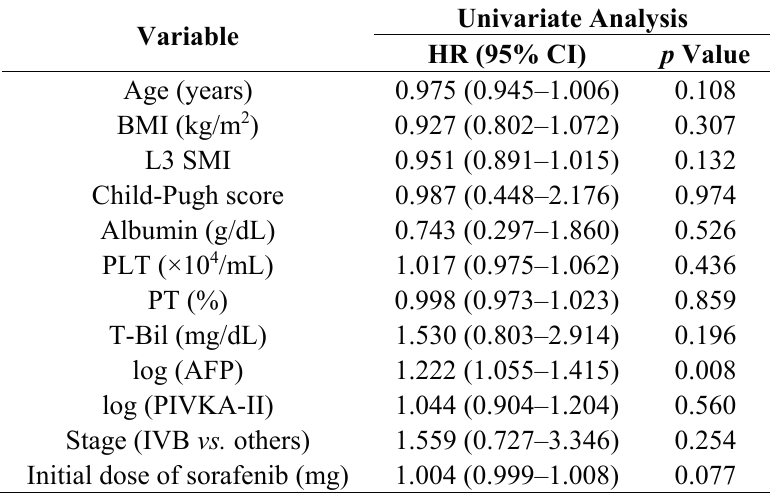
Table 4. Univariate and multivariate analyses of possible risk factors for discontinuation of sorafenib due to its toxicity by Cox proportional hazards